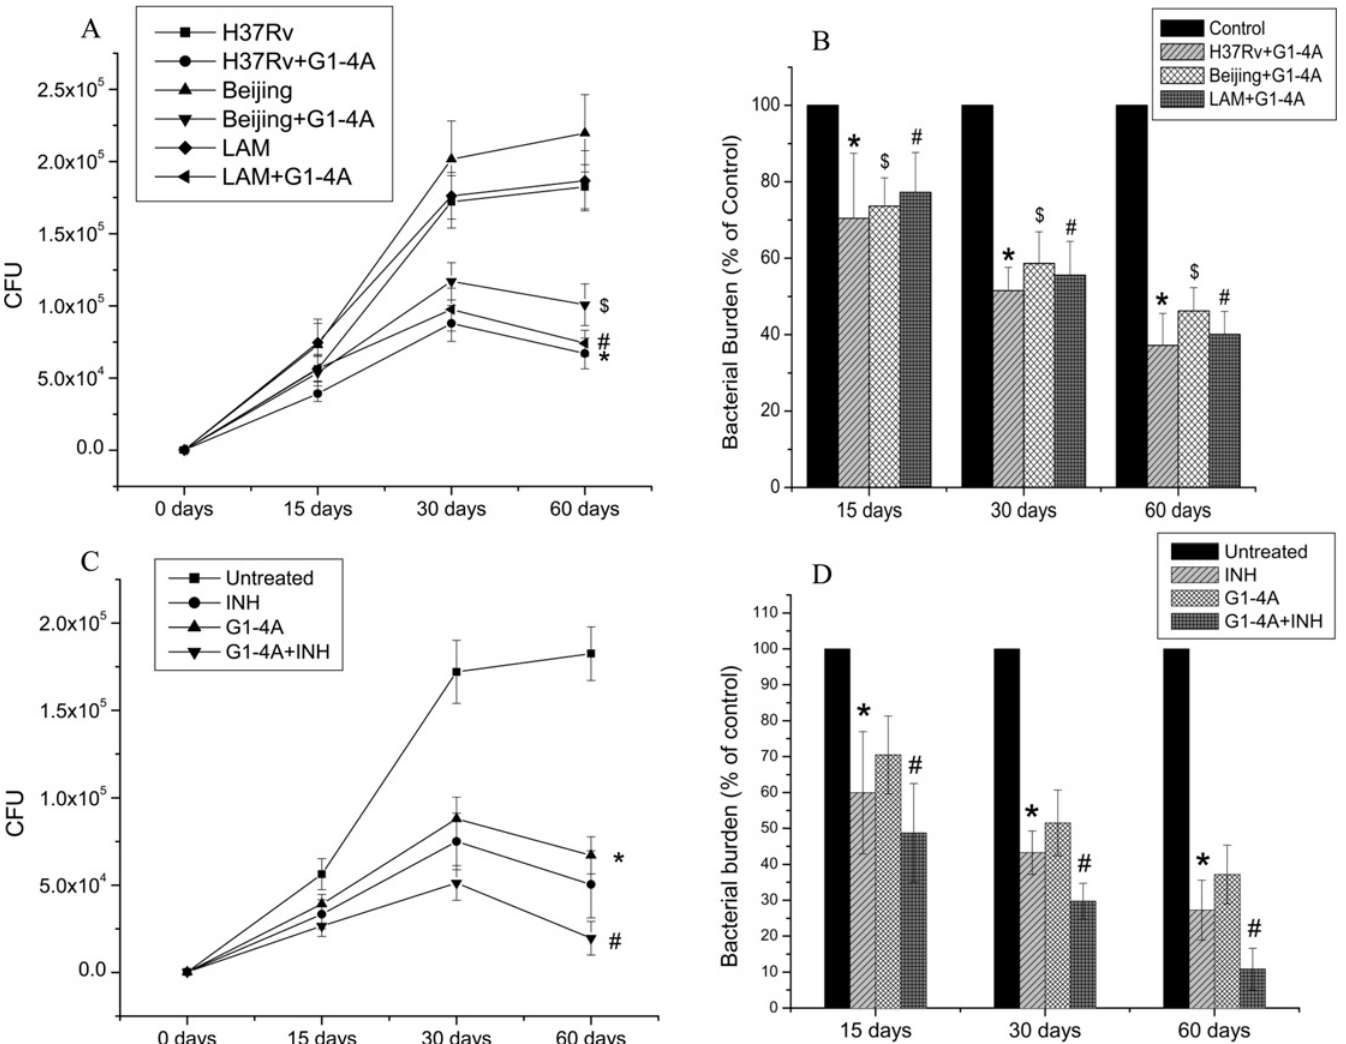
Fig 6. Effect of G1-4A on bacterial burden in MTB infected mice. BALB/c mice infected with MTB strains H37Rv, LAM and Beijing in the presence or absence of G1-4A were sacrificed at 15, 30 and 60 days post infection. Lungs were homogenized and plated on to Middlebrook 7H11 plates after appropriate dilutions. (A) CFU counts (B) Bacterial burden as percentage of untreated controls were plotted, * p < 0.05, $p < , 0.05 #p < 0.05 compared to untreated. (C) In another set of experiment mice were infected only with H37Rv and treated with G1-4A, INH alone or in combination. Animals were sacrificed and lung homogenates were plated onto Middlebrook 7H11 plates for CFU enumeration (D) Bacterial burden as percentage of untreated controls * p < 0.05, $p < , 0.05 #p < 0.01 compared to untreated. Results shown here are representative of at least three independent experiments performed and presented as mean ±